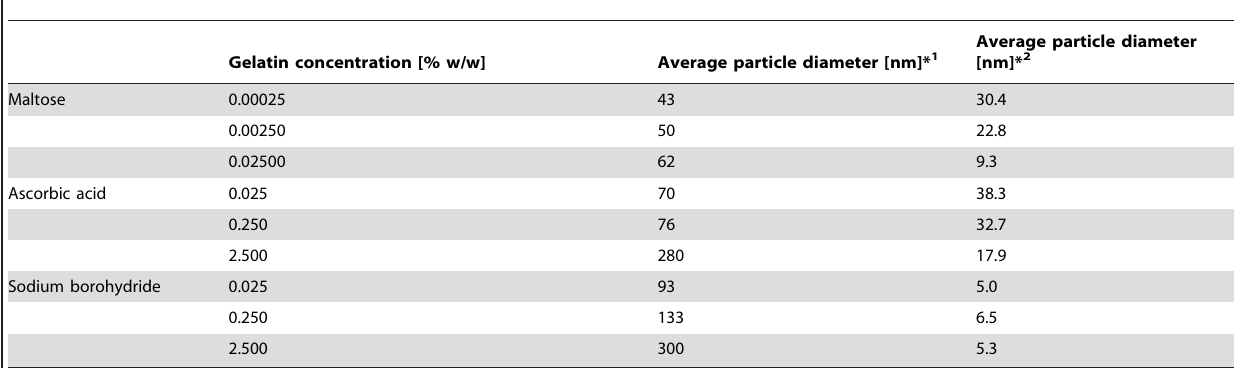
Table 1. Average values of AgNP diameter determined from DLS measurements and from TEM images.